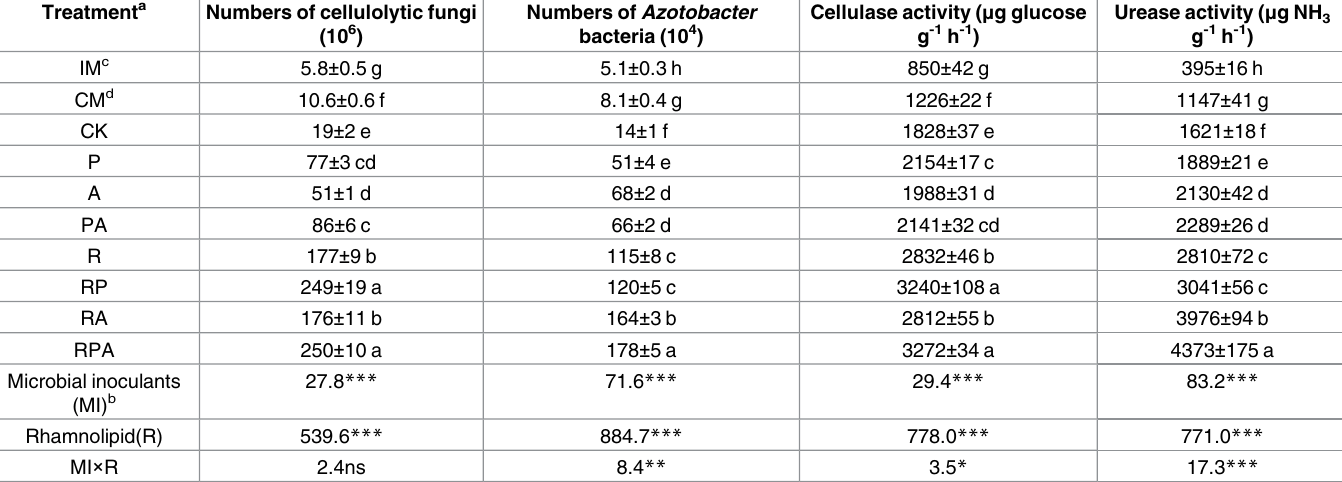
Table 2. Effects of the microbial inoculants and rhamnolipid on the population densities of cellulolytic fungi and Azotobacter bacteria and on cel- lulase and urease activities in vermicomposts. Treatment a